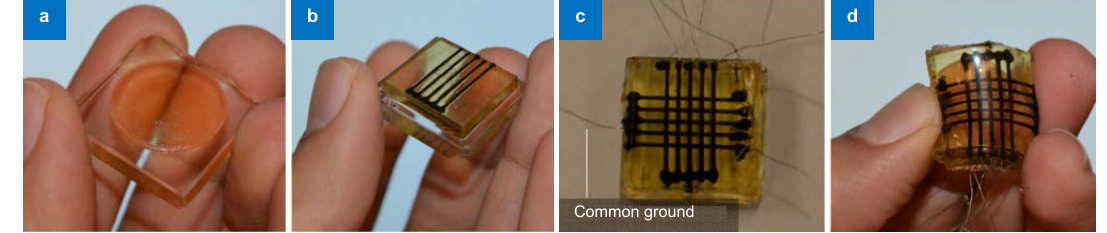
Fig. 10 | Fabricated stretchable tactile sensor using integrated PSL and DP processes 27 . ( a ) An example (partial sphere) of 3D structure built in the PSL system. ( b ) Printed sensing elements using the DP process on the insulating layers built in the PSL system. ( c ) Final sensor with two sensing layers. ( d ) Deformed sensor.